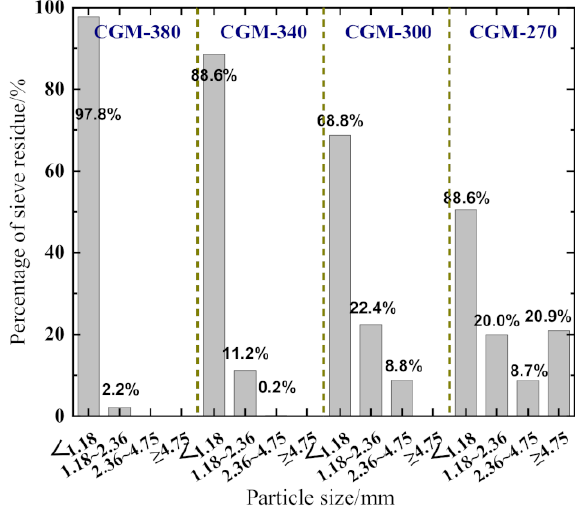
Figure 1. Results of sieving analysis